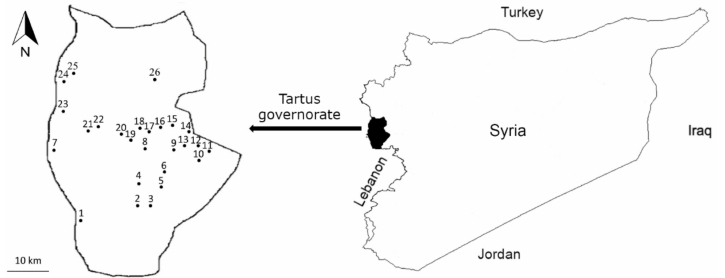
Figure 1. Study area map, the Tartus governorate and studied villages: 1. Al-Hamidiyah, 2. Ain Dabesh, 3. Al-Mitras, 4. Al-Sawma’a, 5. Bishrael, 6. Sibbeh, 7. Tartus, 8. Draykish, 9. Bait Yousef, 10. Husn Suleiman, 11. Annabi Saleh, 12. Annabi Matta, 13. Bestan Assouj, 14. Ain Dlaimah, 15. Fajlit, 16. Al-Tuffaha, 17. Kafr Tallesh, 18. Krafes, 19. Al-A’ujah, 20. Kawkab, 21. Bazughah, 22. Brmmanet Raad, 23. Maten Al-Sahel, 24. Al-Rawda, 25. Dahr Safra, 26.